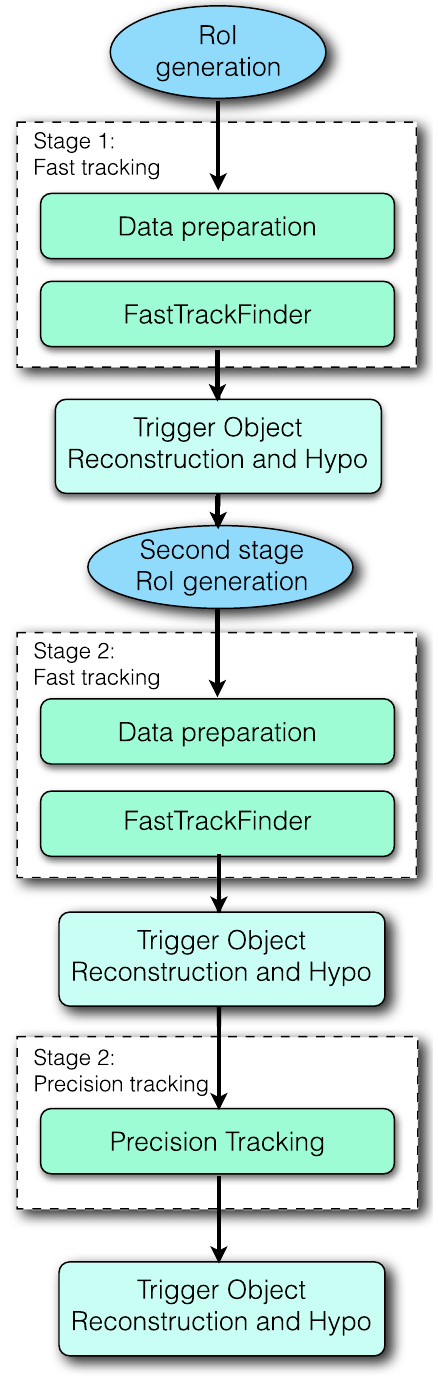
Fig. 7 Schematic illustrating the multistage tracking. Here multistage referstothemultiplepassesofthetrackprocessingoverspecificpartsof the detector, perhaps with an updated, or otherwise modified RoI. As in the single-stage case, selection can be applied in hypothesis algorithms (hypos) between any of the tracking steps in the two stages